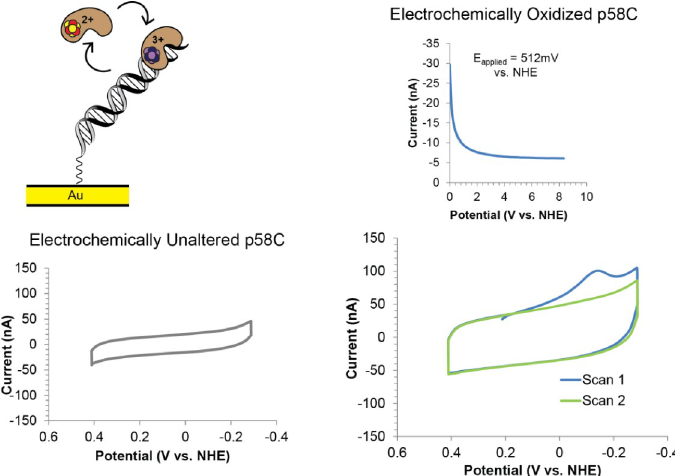
Fig 7. p58C 266-464 participates in redox switching on DNA. The cartoon (top left) depicts p58C DNA binding and redox switching on an Au electrode. (Bottom left) CV scan of electrochemically unaltered p58C 266-464 . (Right) bulk oxidation (above) of p58C 266-464 and subsequent CV scans (below). This construct displays similar electrochemical behavior to p58C 272-464 . All electrochemistry was performed in anaerobic conditions with 40 μ M [4Fe4S] p58C 266-464 in 20 mM HEPES (pH 7.2), 75 mM NaCl. CV was performed at 100 mV/s scan rate.